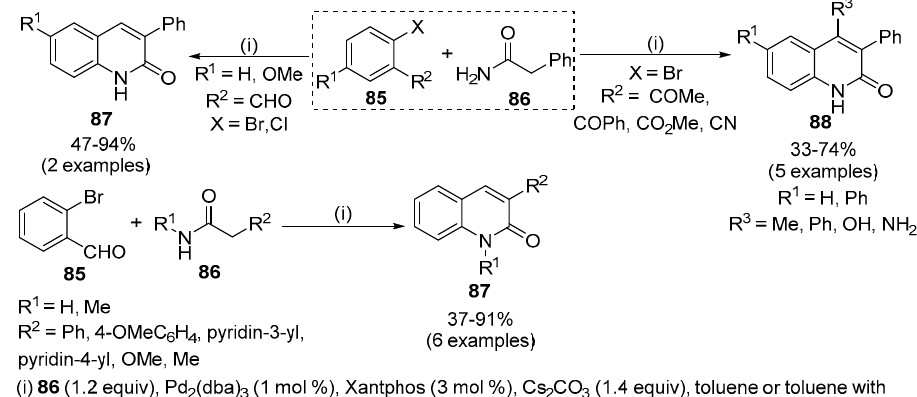
Scheme 28. Synthesis of quinolin-2(1 H )-ones 87 and 88 by tandem Pd(0)-catalysed